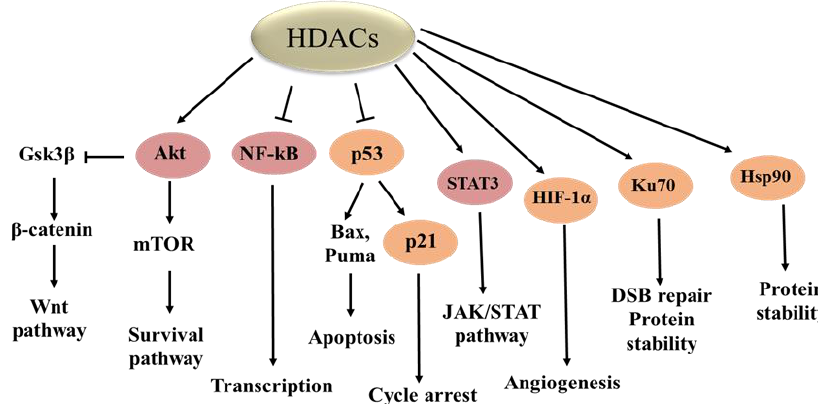
Figure 1. Non-histone protein substrates of histone deacetylases (HDACs) regulate tumor cell proliferation, cycling, apoptosis, and DNA damage repair. GSK3β, glycogen synthase kinase3β; DSB, double-strand break.